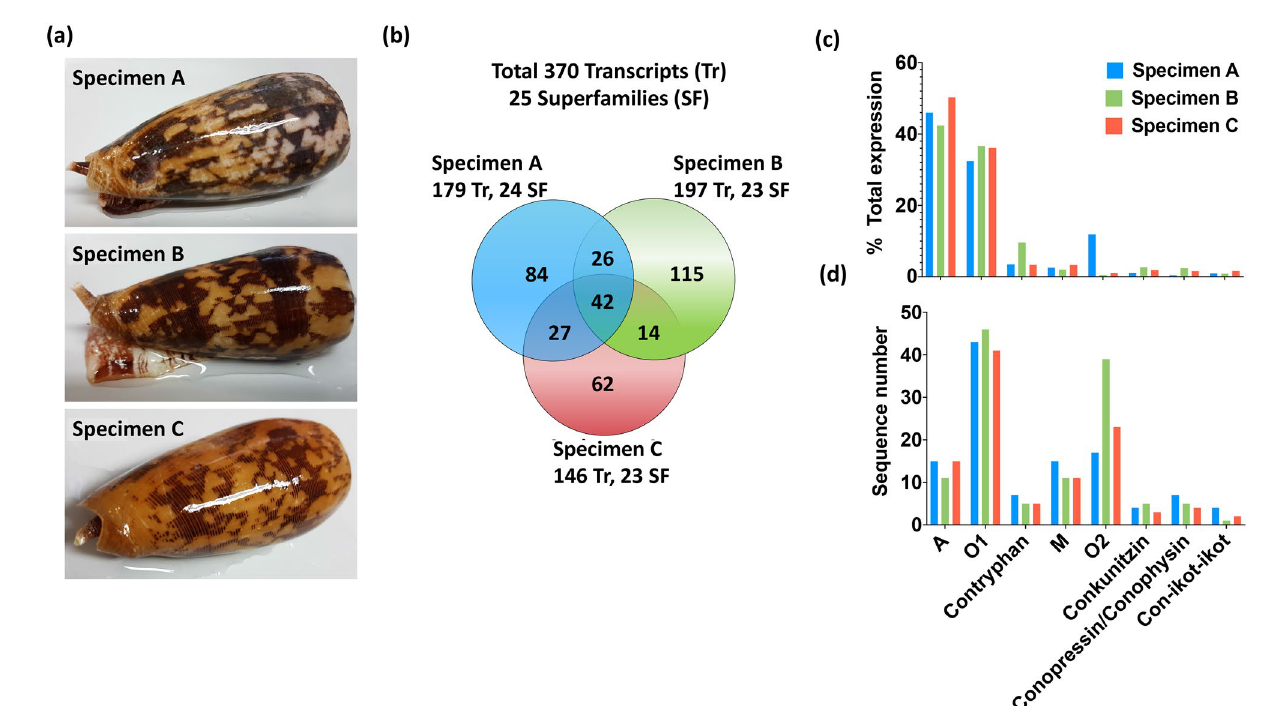
Figure 1. Intraspecific venom transcript variation in between three adult C. striatus (specimens A–C). (a) Photographs of the three specimens of adult C. striatus used in the study. (b) Venn diagram showing the common and unique conotoxin precursor transcripts among the three specimens of C. striatus. (c) Expression levels of the dominant conotoxin gene superfamilies across the three specimens. Relative expression levels were calculated for each superfamily using the TPM values. (d) The number of conotoxin precursors found in the dominant gene